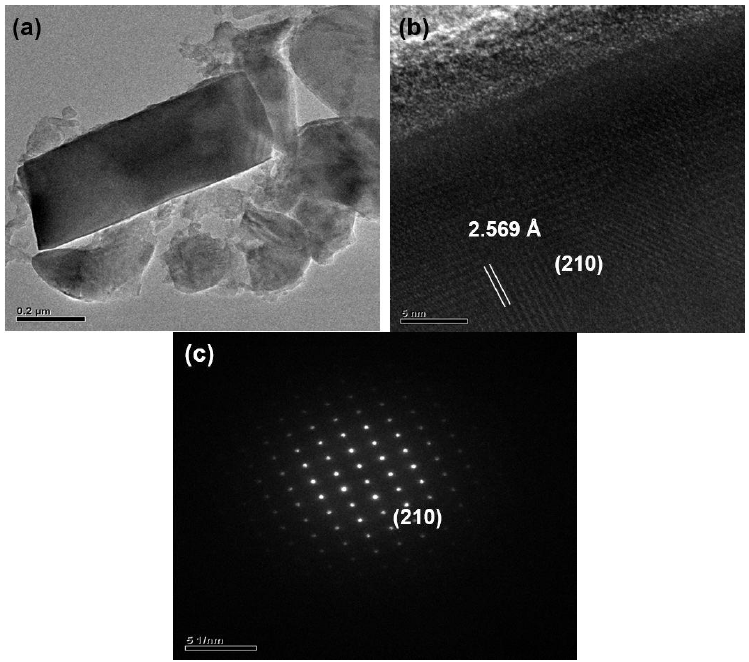
Figure 5. ( a ) TEM image; ( b ) HRTEM image; and ( c ) SAED pattern of a plate-like particle (showing it to be Ca-α-SiAlON:Eu 2+ ) in a product synthesized with Ca:Al:Si:Si 3 N 4 :Eu 2 O 3 :NaN 3 :NH 4 Cl = 0.25:1.0:0.25:0.25:0.02:3.5:0.6.